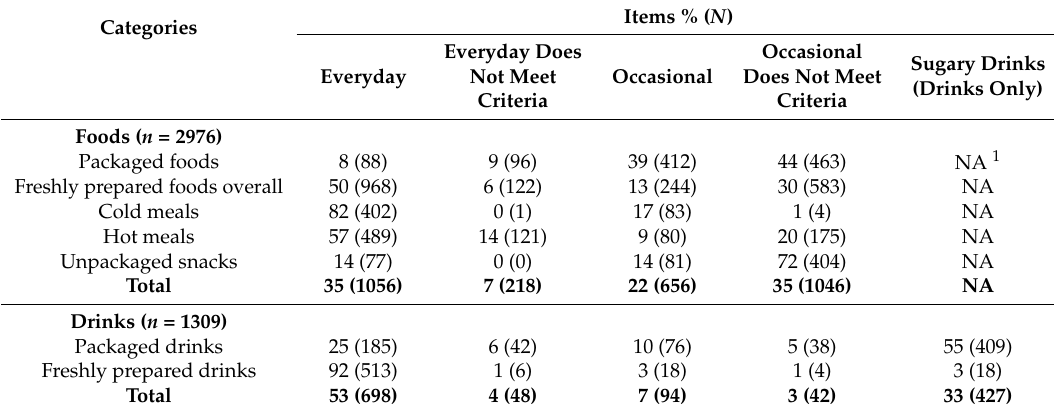
Table 3. Foods and drinks classification across all 30 audited food